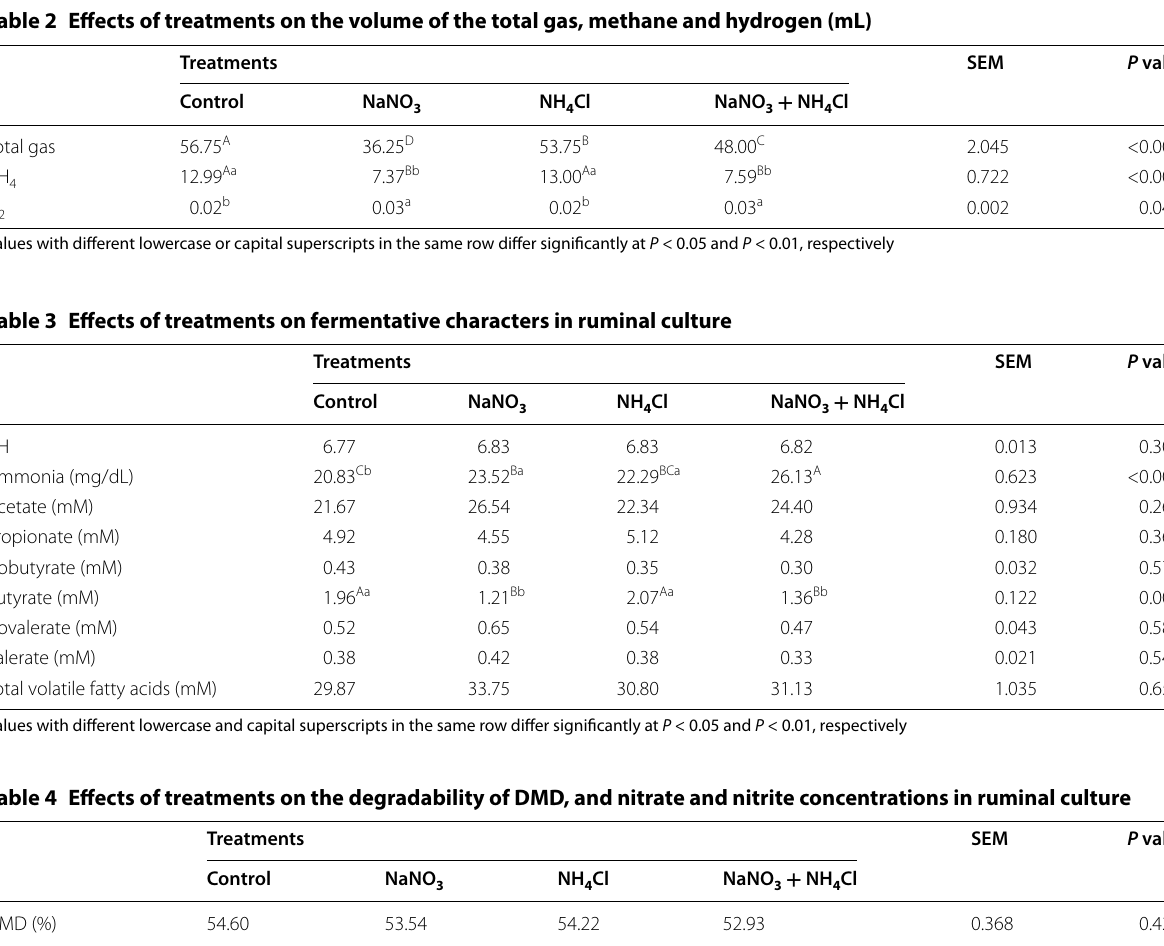
Table 2 Effects of treatments on the volume of the total gas, methane and hydrogen (mL)